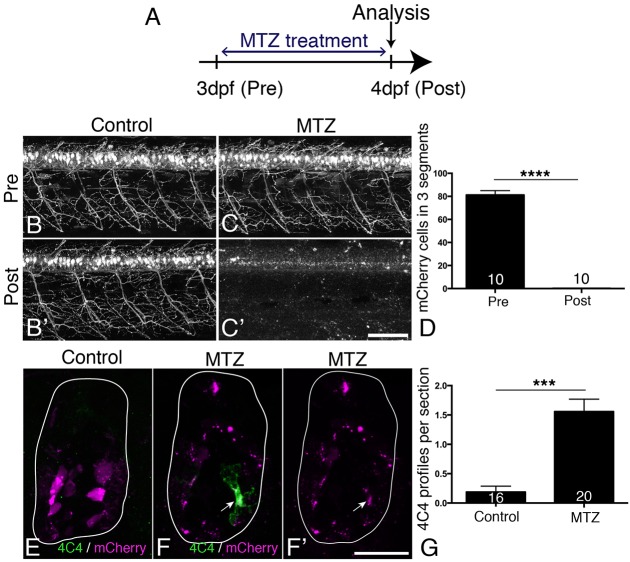
MTZ treatment leads to ablation of all transgene-expressing cells and to microglia/macrophage activation. (A) Treatment time line. (B-D) mCherry+ motor neurons and their axons are visible in untreated control larvae at 3 and 4 dpf (B,B′), but mCherry labelling is completely lost after 24 h treatment with MTZ (C,C′), quantified in D (Mann–Whitney U-test, ****P<0.0001). (E-G) Cross sections show that mCherry-labelled cells fragment during MTZ treatment and that microglia/macrophages appear and phagocytose the cell debris (arrow in F,F′). Microglia/macrophages are quantified in G (Mann–Whitney U-test, ***P<0.0001). Values are means±s.e.m. Scale bars: 100 µm in C′ for B-C′; 25 µm in F′ for E-F′.